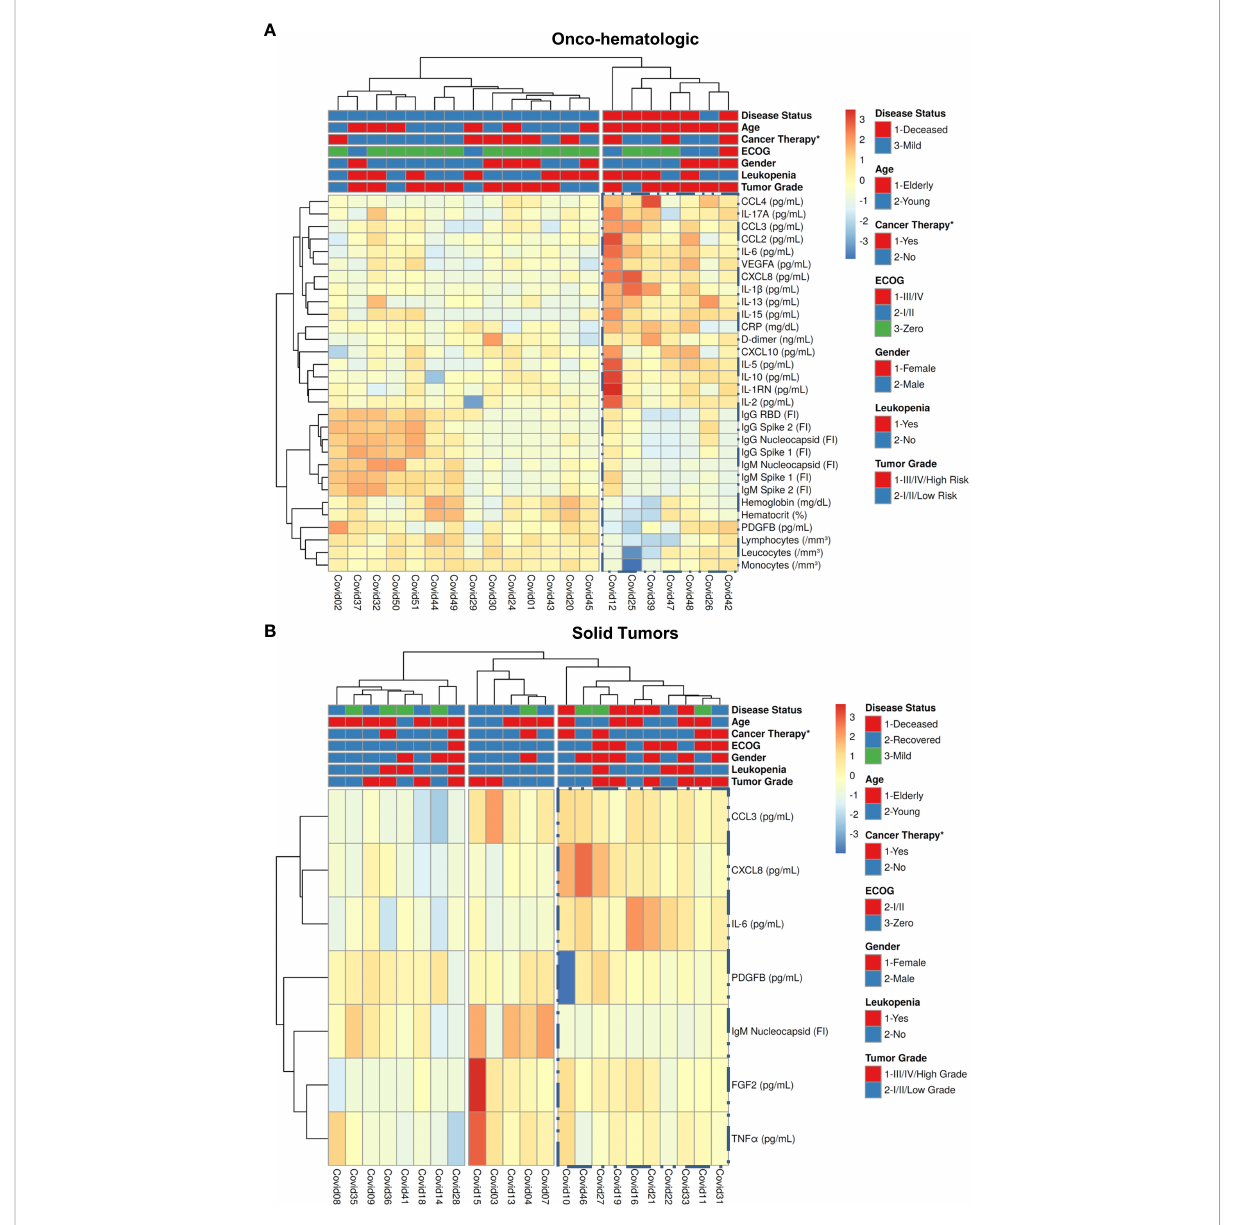
FIGURE 5 High levels of immune mediators, low IgG anti-SARS-CoV-2, and low leukocyte subpopulations segregate Severe-Death patients with hematologic malignancies from those with Mild disease outcomes. Blood samples were collected within two days (median; 1 – 4 CI) of the positive SARS-CoV-2 diagnostic and analyzed for 27 immune mediators and for immunoglobulins anti-SARS-CoV-2 proteins, as described in Materials and Methods. Groups of hematologic cancer patients (A) and solid tumors patients (B) were de fi ned based on disease severity as described. All data was normalized by natural logarithm + 1 [ln(x +1)] before running an unsupervised cluster analysis and generation of the heatmap using ClustVis platform as described in Materials and Methods. In (A) both rows and columns were clustered by Manhattan distance and Complete linkage. In (B) both rows and columns were clustered by Euclidean distance and Ward linkage. Nucleocapsid, RBD, Spike 1 and Spike 2 labels refers to antibodies anti-SARS-CoV-2 proteins. CRP, C-Reactive Protein; RBD, Receptor Binding Domain. *Refers to active cancer therapy one month prior to COVID-19